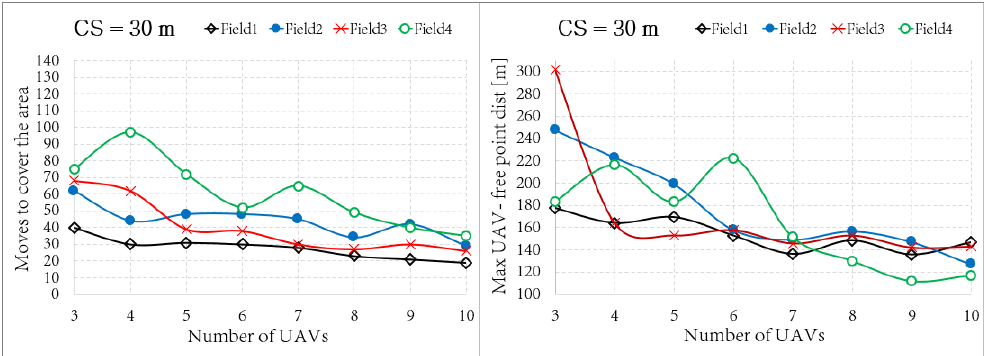
Figure 8. Results obtained after the fleet’s uniform distribution optimization shown in Figure 10.